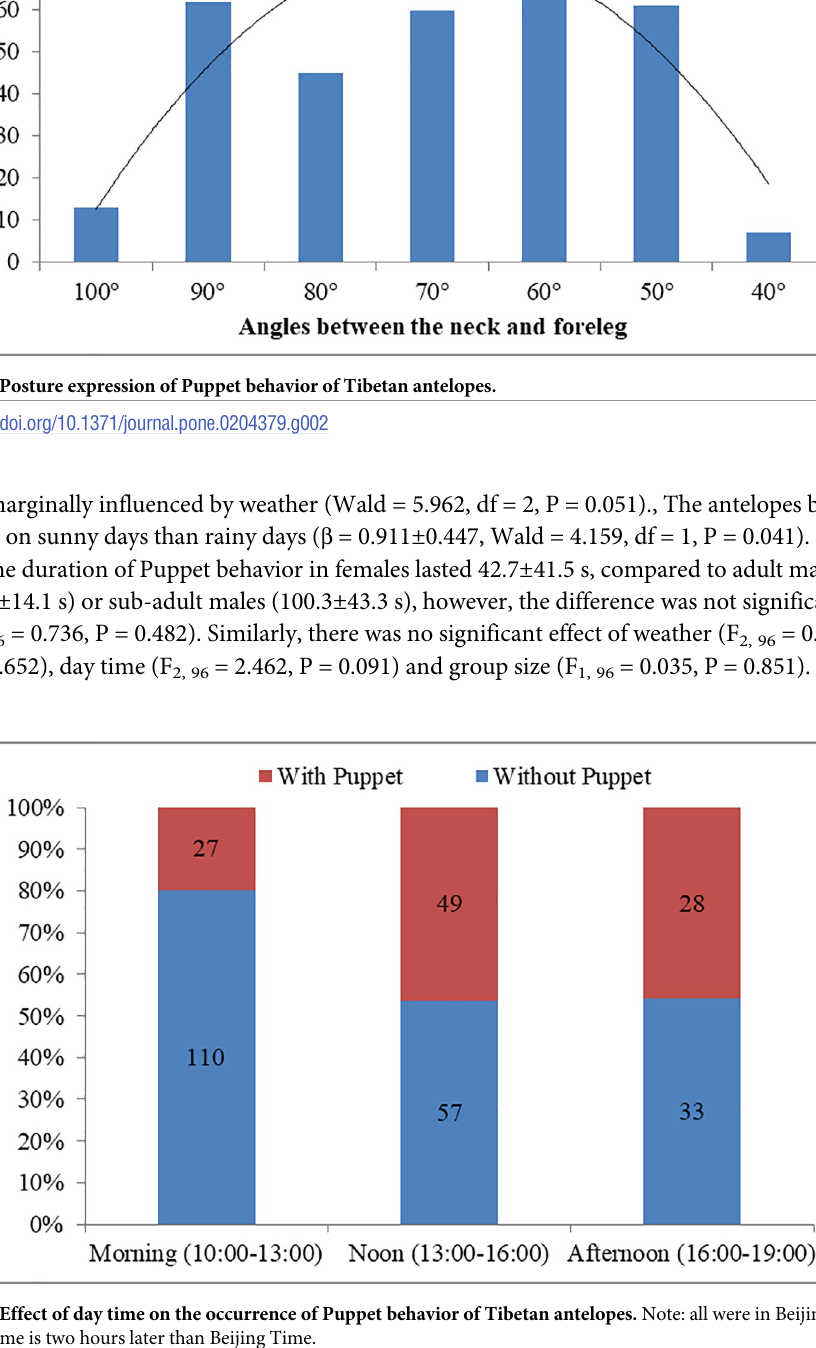
Fig 3. Effect of day time on the occurrence of Puppet behavior of Tibetan antelopes. Note: all were in Beijing Time; local time is two hours later than Beijing Time.